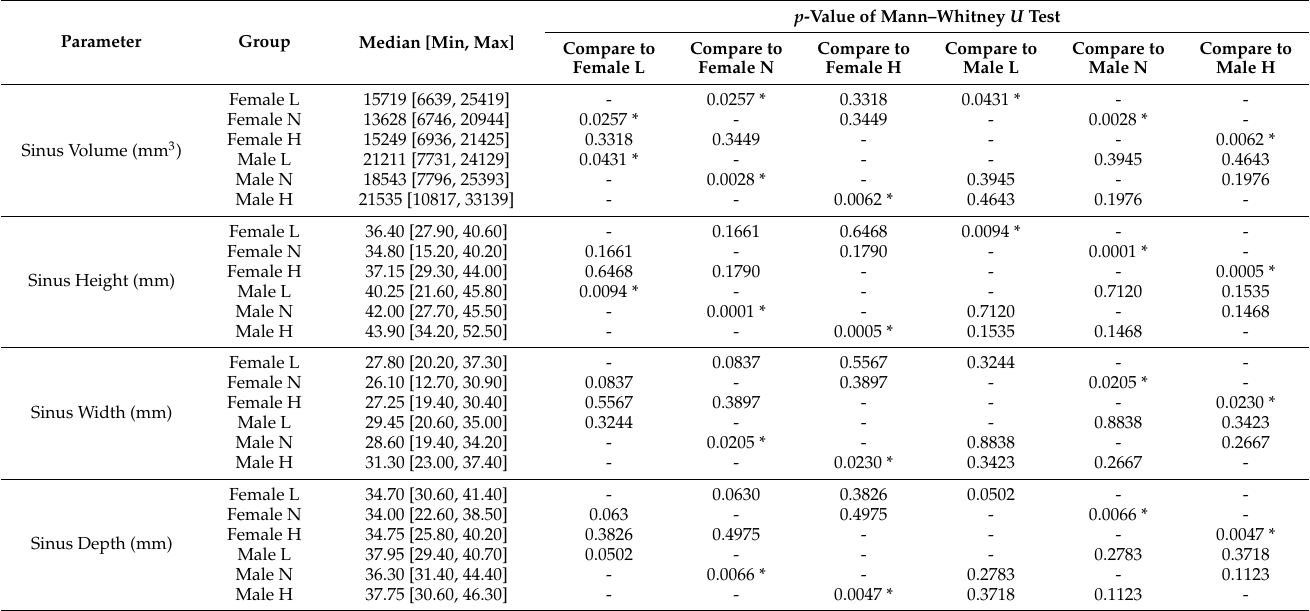
Table 2. The comparison of maxillary sinus size among groups. L: low angle; N: normal angle; H: high angle. *: p <